Question: Which kind of chart has been used to present this data?
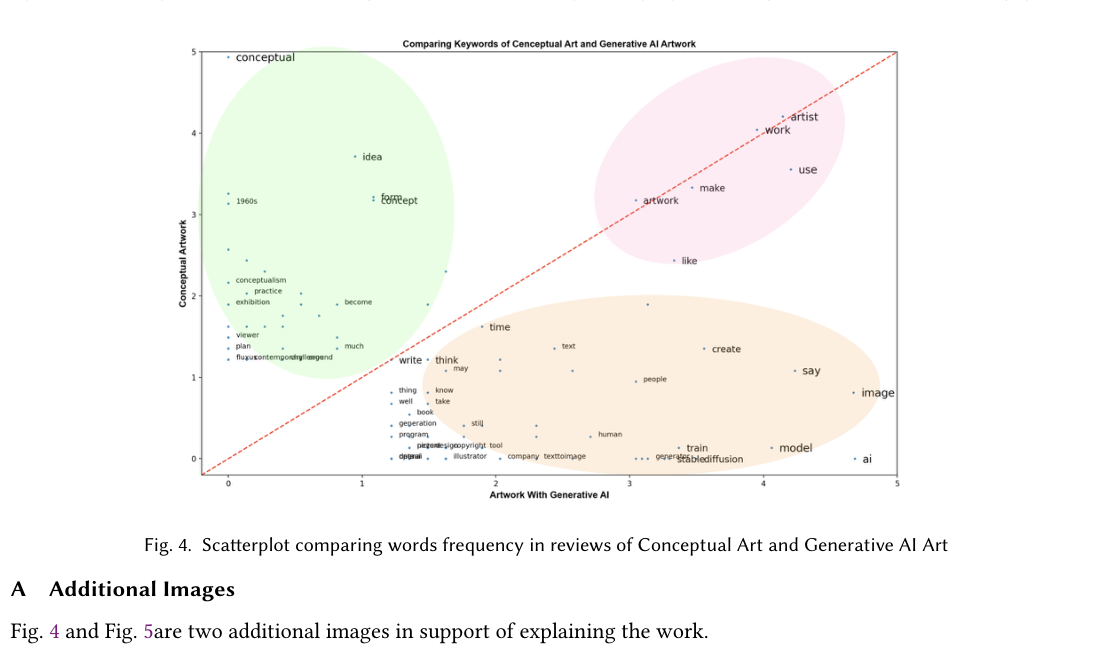
Answer: scatter